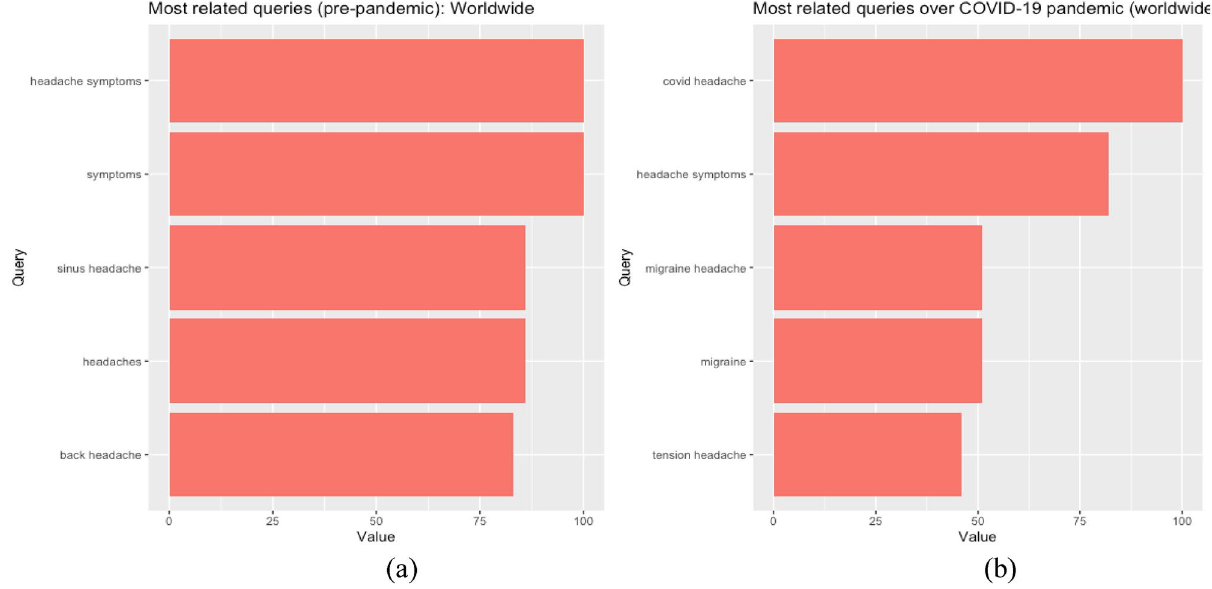
Figure 2. Most related queries to the search term “headache”: Pre-pandemic period (February 2017–January 2020) ( A ); pandemic period (February 2020–February 2022) ( B ).